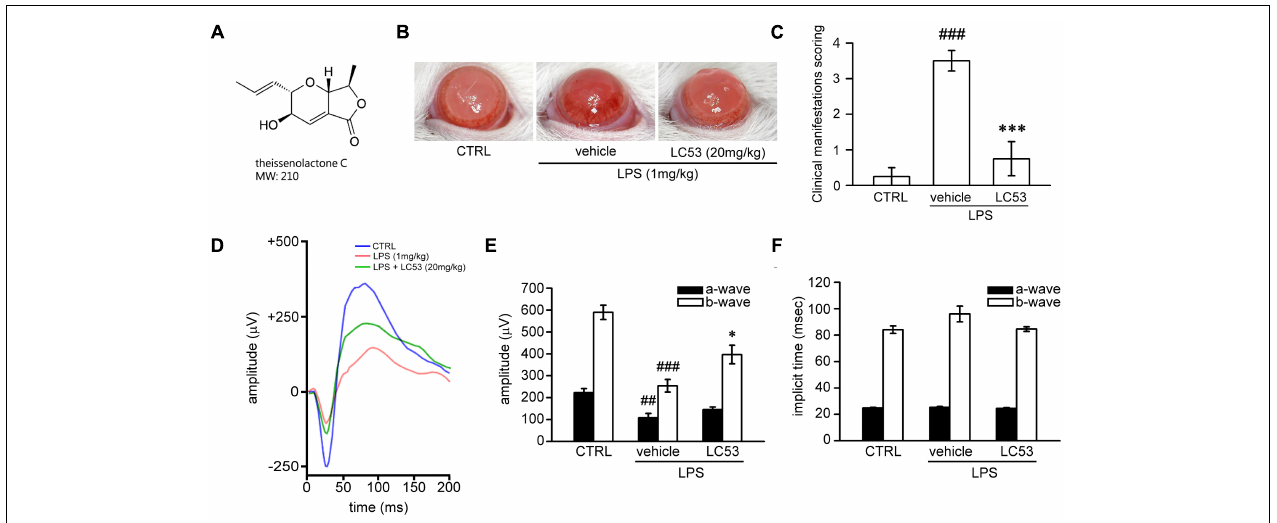
FIGURE 1 | LC53 potentially protected against LPS-induced intraocular inflammation and prevented LPS-injured retinal function. (A) The chemical structure of LC53 (MW = 210). (B) Anterior ocular inflammation was evaluated by microscopic examination in anterior segment 72 h after footpad injection of lipopolysaccharide (LPS, 1 mg/kg). Representative ocular photography was taken at 72 h following LPS-induction in SD rat. (C) Clinical scoring for inflammation level of EIU in the absence ( n = 4) or presence of LC53 (20 mg/kg, n = 4) and in control group ( n = 4) were determined. (D) Representative scotopic ERG responses from control mice (blue curve), and EIU rat treated with the vehicle control (red curve) or LC53 (green curve) were recorded 1 day after LPS-injection. (E,F) Quantification of the average amplitudes and implicit time (time to peak) from control rat ( n = 6), and EIU rat treated with the vehicle control ( n = 6) or LC53 ( n = 5). The ERG a-waves were negative, and the a-wave amplitudes were presented as the absolute value. The results were presented as the mean ± SEM. CTRL: control. ## p < 0.01, ### p < 0.001 compared with the control group treated with normal saline; ∗ p < 0.05, ∗∗∗ p < 0.001 compared with EIU group treated with